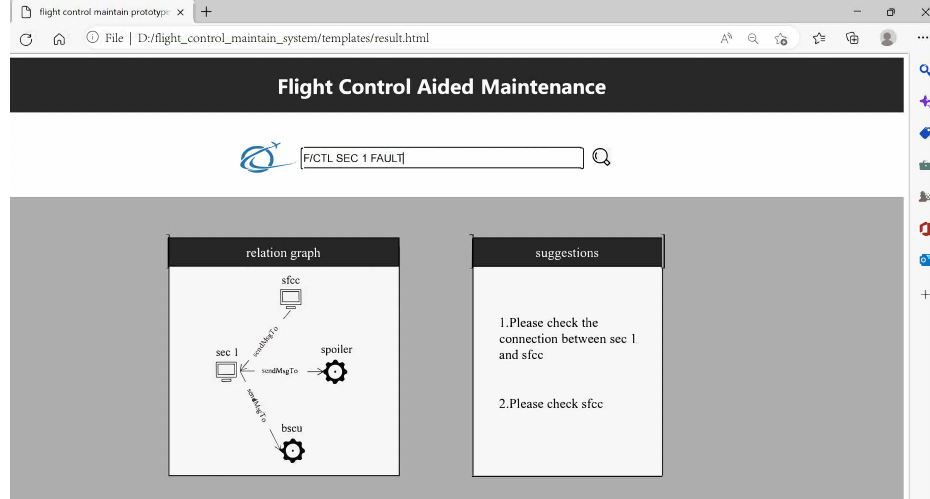
Figure 11. Example of querying “F/CTL SEC 1